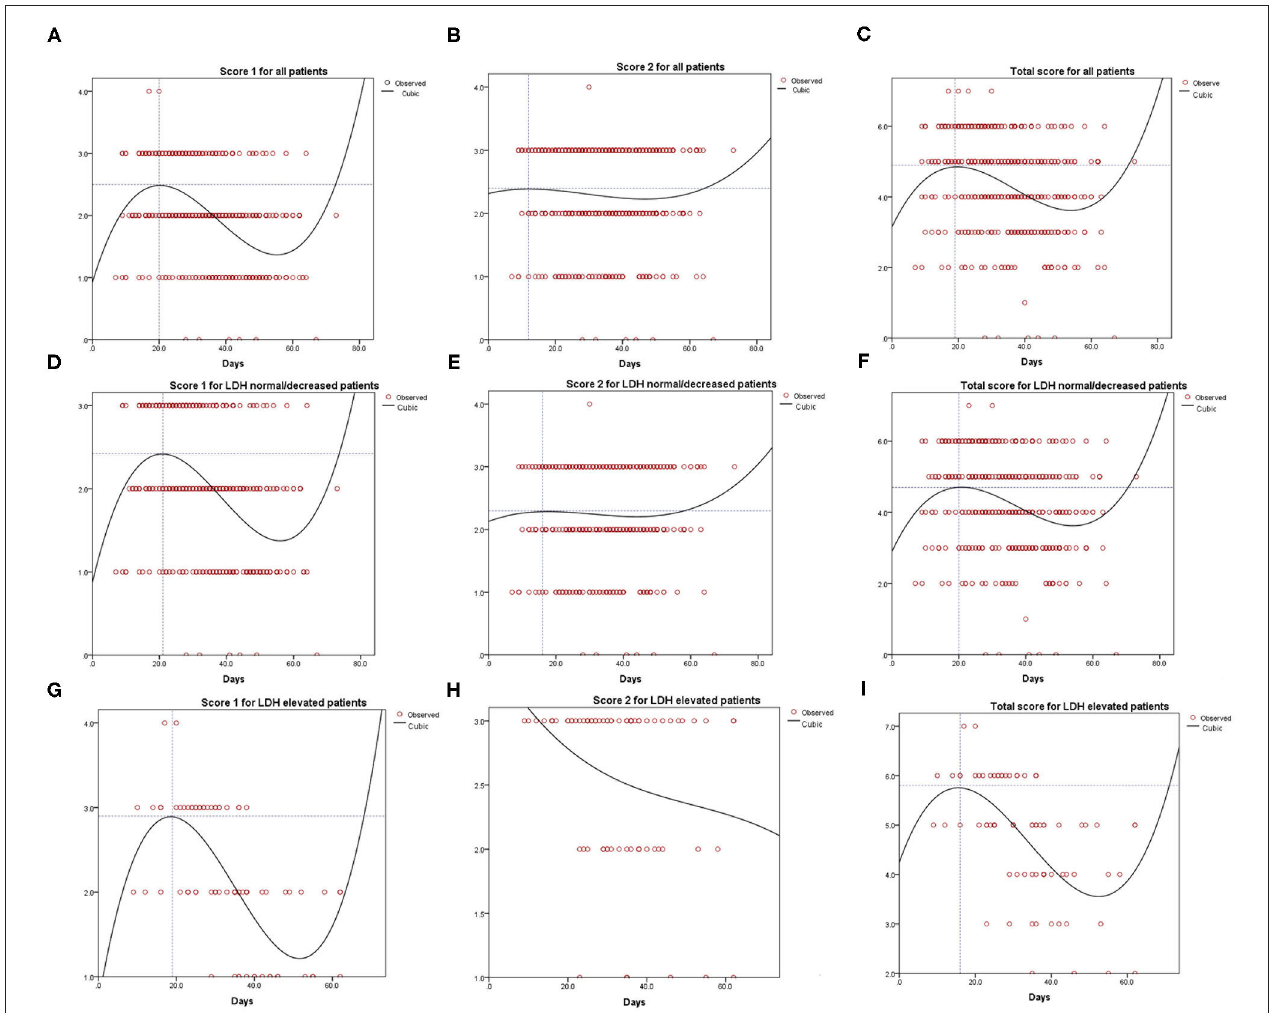
FIGURE 3 | Curve fitting analysis for all the COVID-19 patients (A–C) , LDH normal or decreased group (D–F) and LDH evaluated group (G–I)